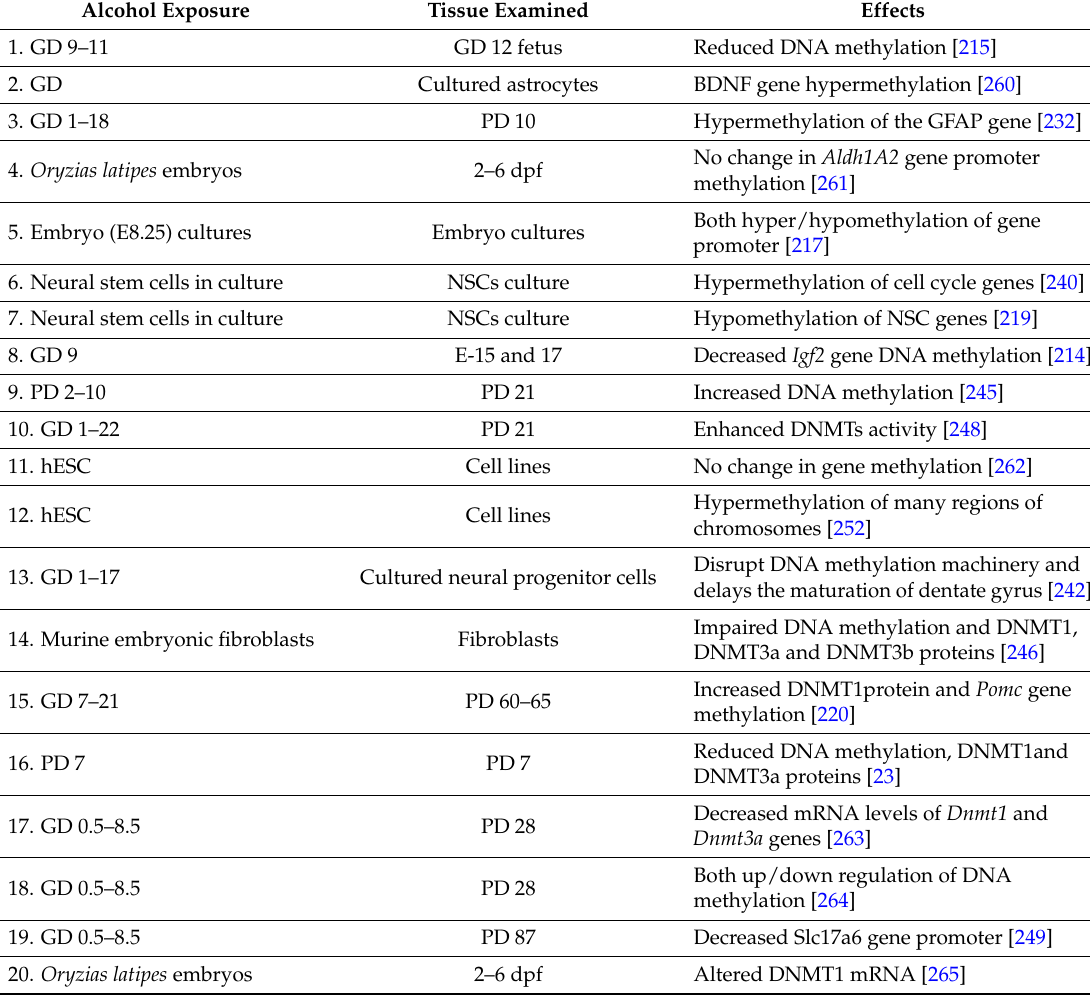
Table 1. Summary of the developmental alcohol-induced DNA methylation